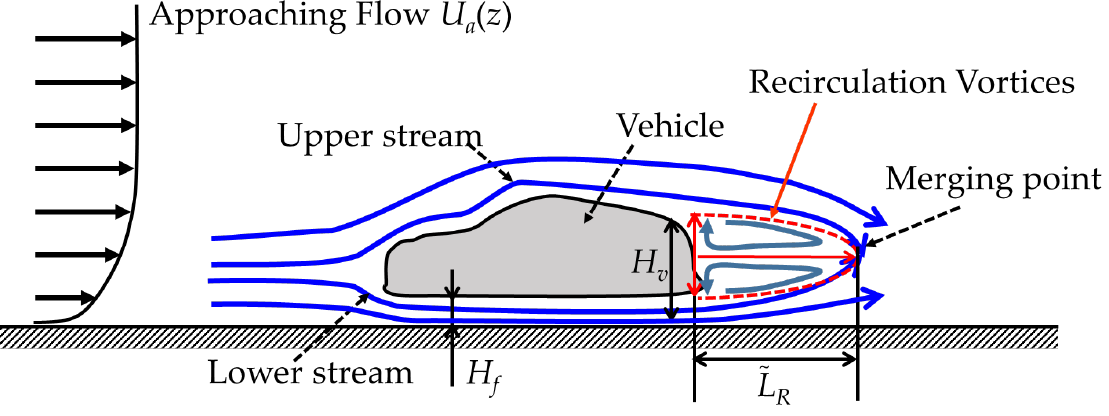
Figure 2. Illustration of the flow pattern around a vehicle, along the centerline of the y -direction, in the x - z plane. Two recirculation vortices are formed in the near-wake region of a